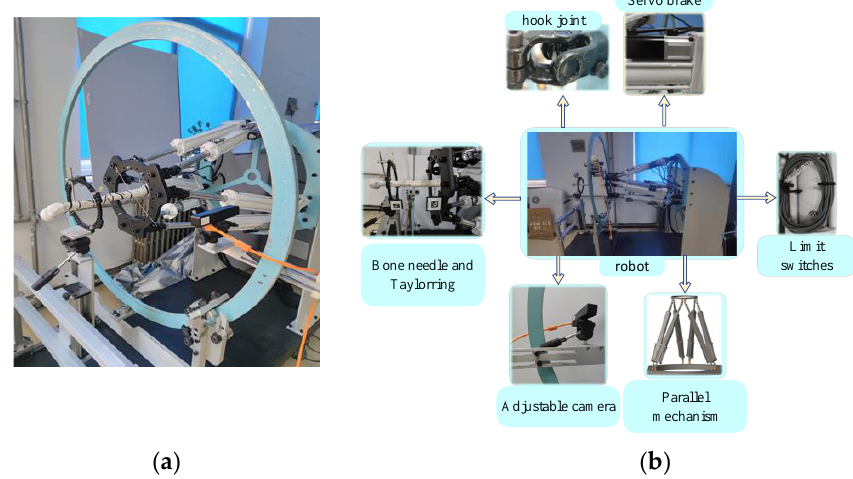
Figure 1. Structural design of the fracture reduction robot: ( a ) overall view; ( b ) key parts view.